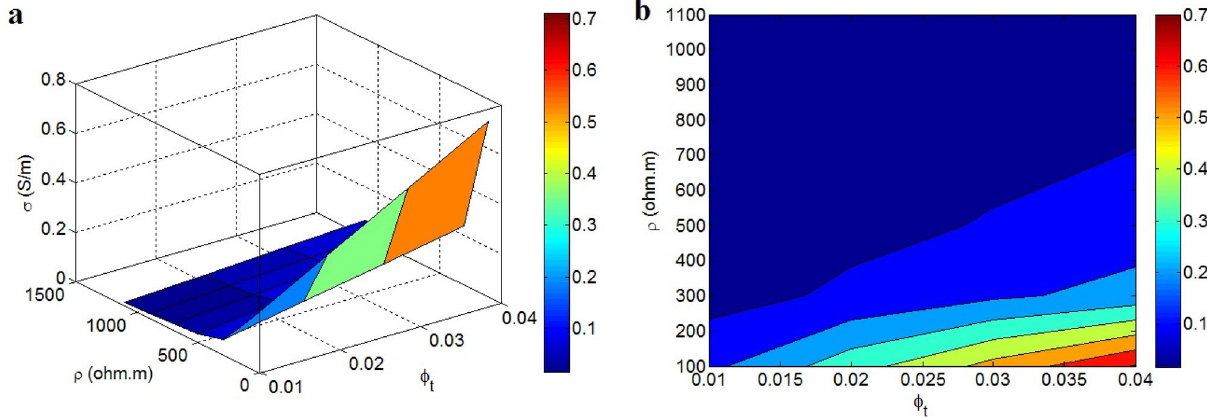
Figure 9. ( a ) 3D and ( b ) contour plans for the impresses of “ ϕ t ” and “ρ” on the efficient